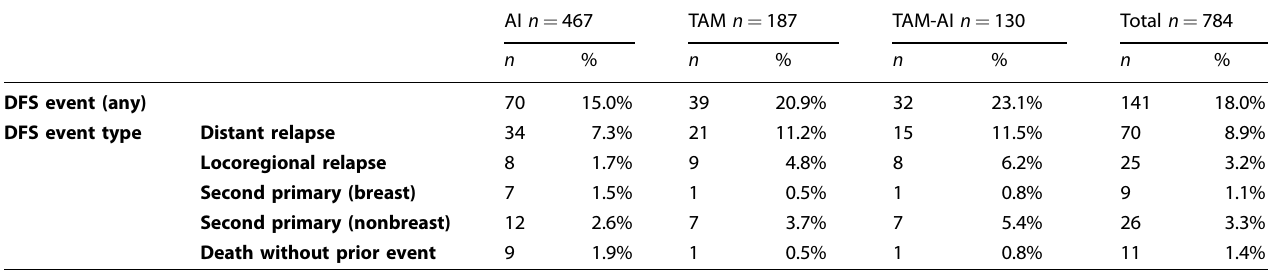
Table 2. Summary of DFS events according to treatment group.